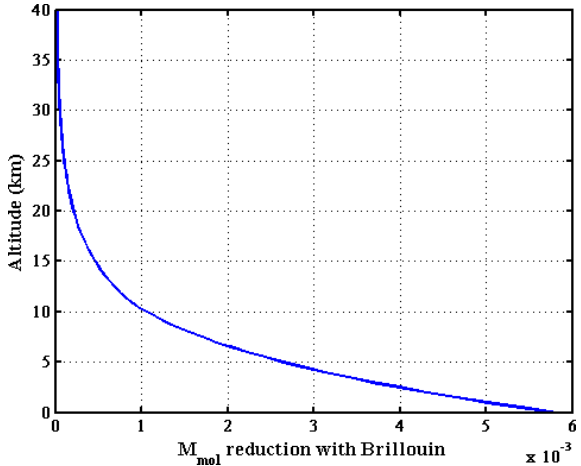
Figure D1. Reduction in M mol caused by the Brillouin